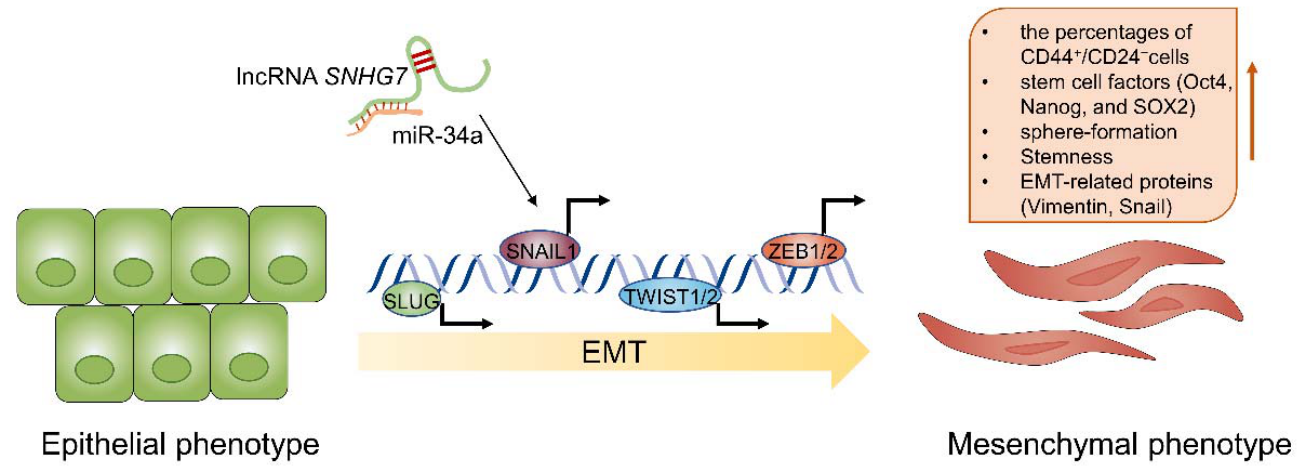
Figure 6. Scheme of the proposed mechanism related to lncRNA SNHG7 in EMT process. SNHG7 , as a molecular sponge of miR ‐ 34a, mediating EMT process, which is driven by EMT ‐ transcription factors (SLUG, SNAIL1, TWIST1/2, ZEB1/2) that repress epithelial marker genes and activate mes ‐ enchymal marker genes. EMT, Epithelial–mesenchymal transition; SNHG7 , small nucleolar RNA host gene 7.